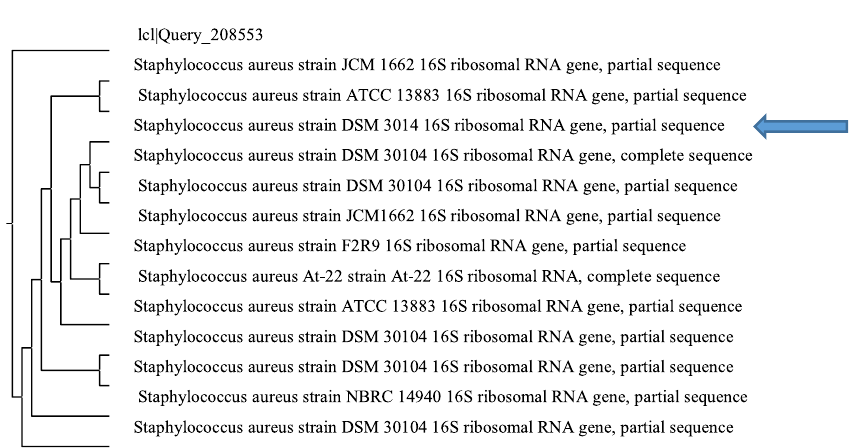
Fig. 1. A dendogram showing the sequence relationships between, Staphylococcus aureus strain DSM 30104 (117686) using 16S ribosomal RNA gene, partial sequence, and several other Staphylococcus aureus strains based on 16s r RNA gene